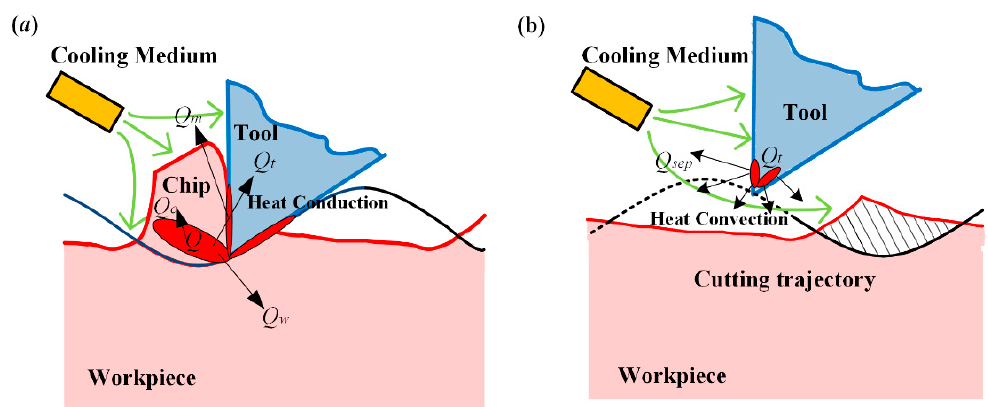
Figure 13. Schematics of the cutting mechanism in ( a ) cutting duration and ( b ) separation